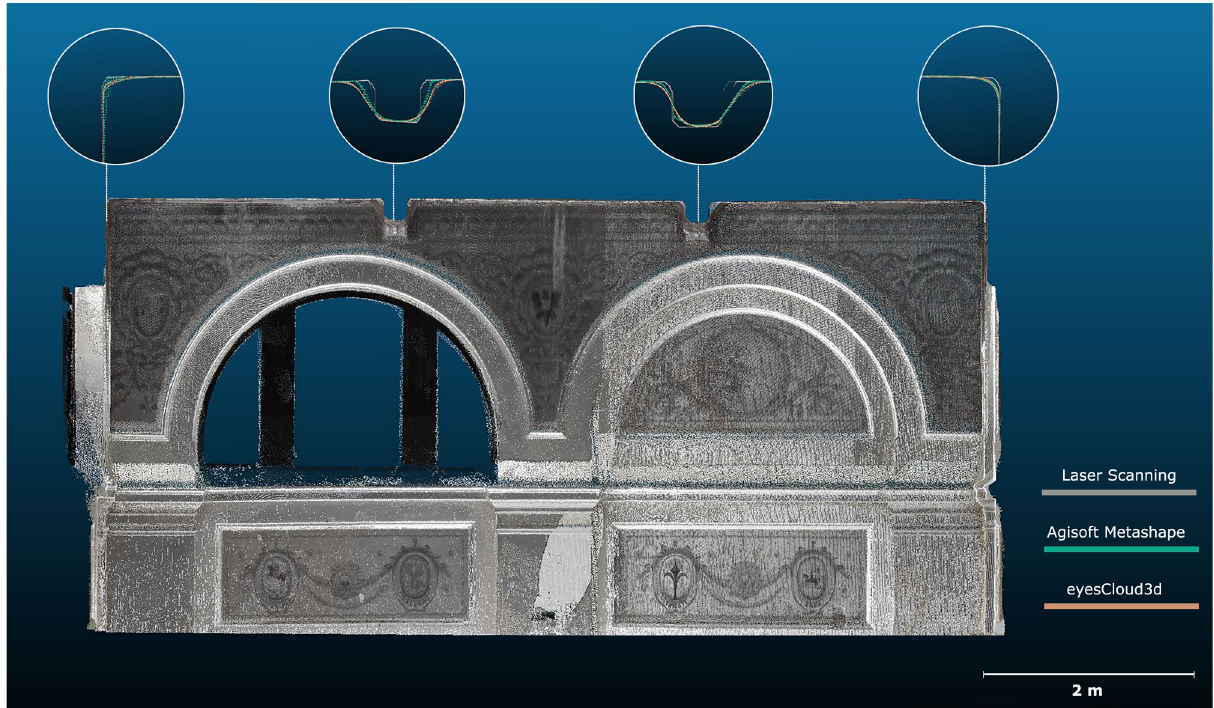
Figure 8 . Zoomed-in sections of the point cloud that show the mainly differences in proximity of edges between the Laser scanner model and photogrammetric